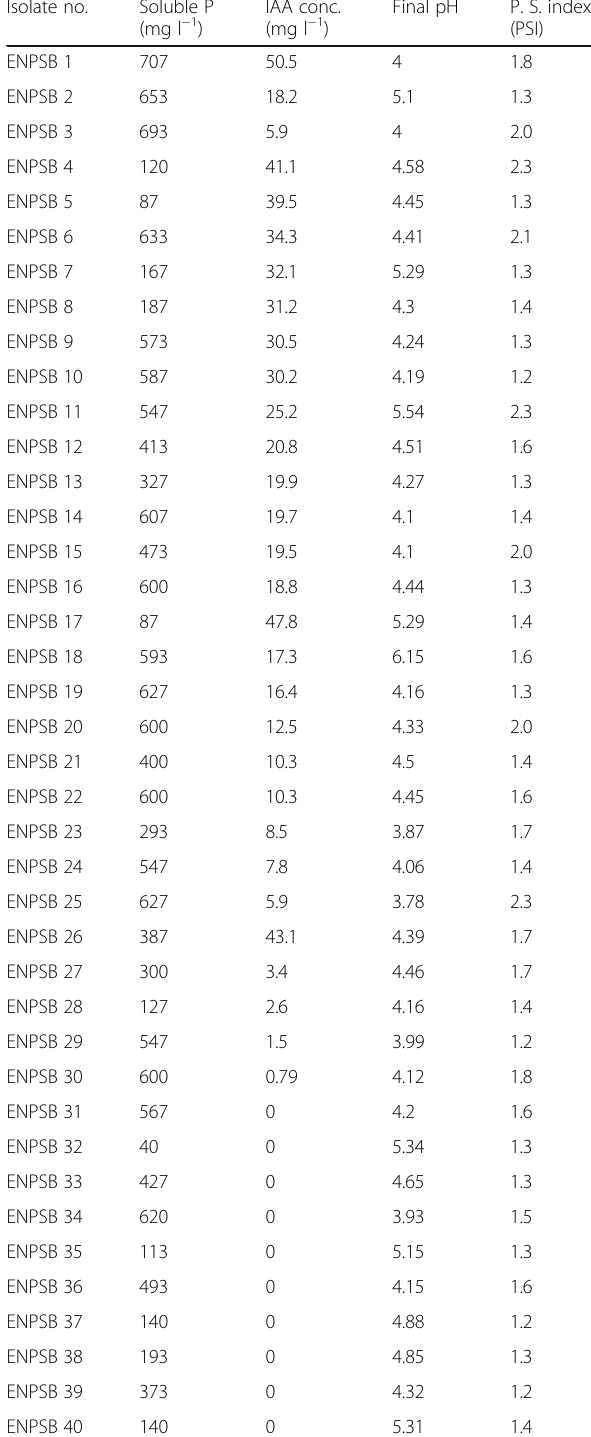
Table 1 Quantitative estimation of bacterial isolates for P solubilization and IAA production Isolate